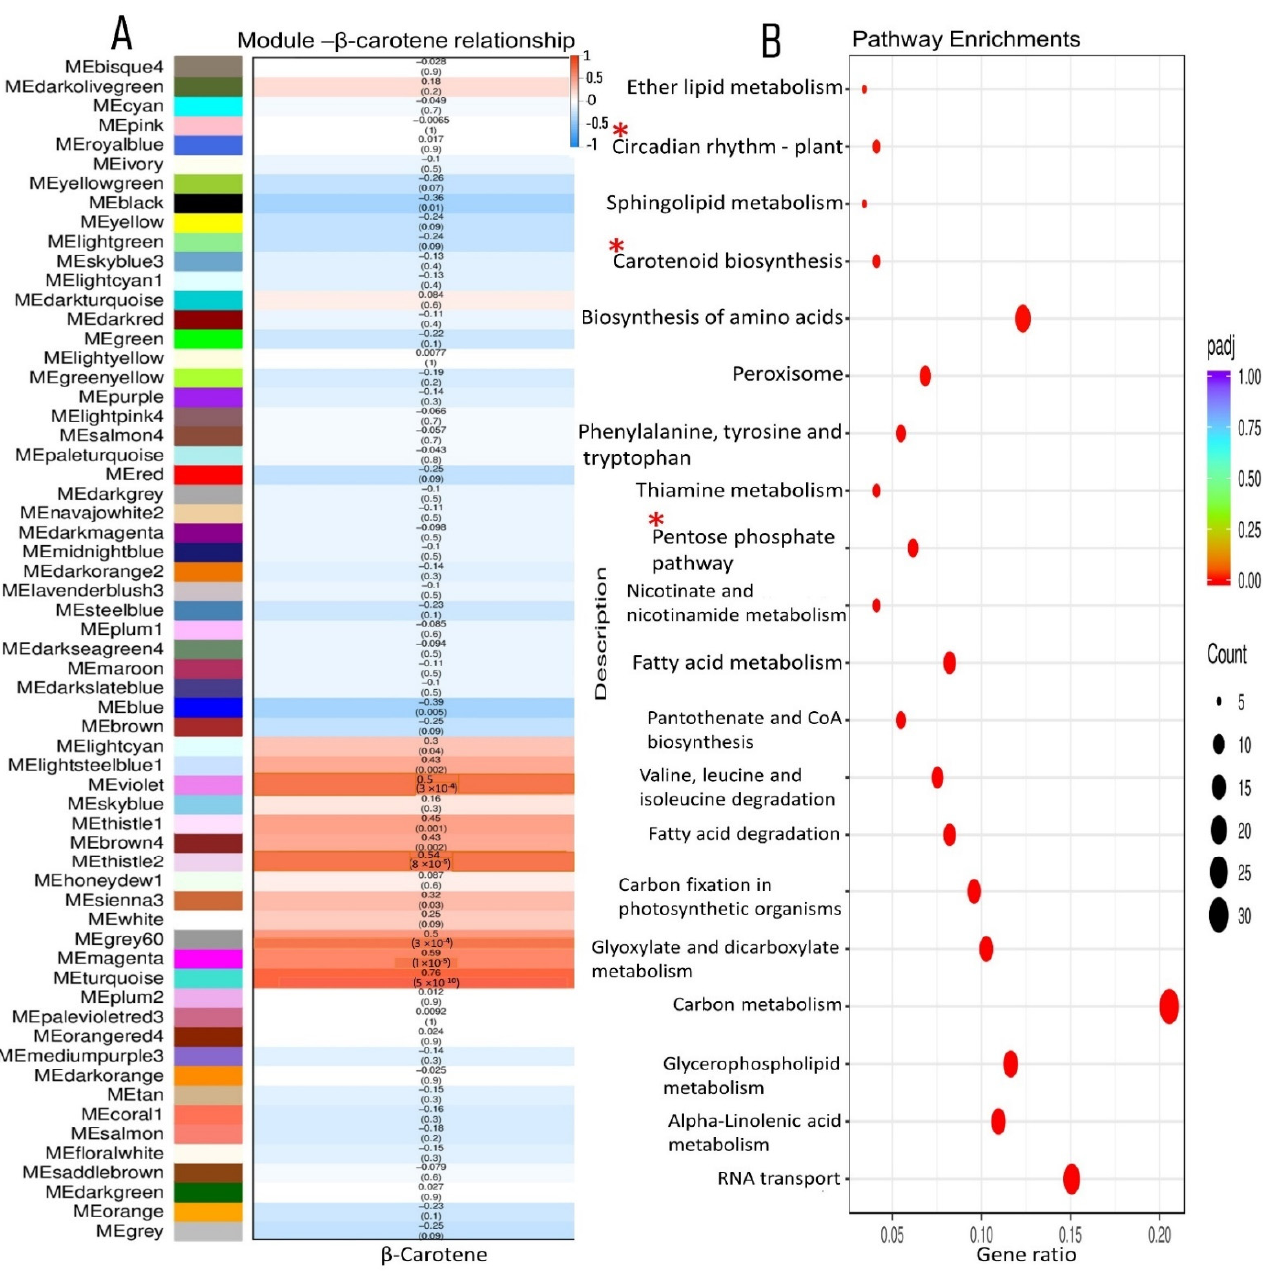
Figure 8. Co-expression networks and associated KEGG pathway enrichment of β -carotene and modules relationships. ( A ) Correlations between modules and β -carotene content; ( B ) Pathway enrichment of genes in the turquoise module positively correlated with β -carotene (R = 0.76). The red stars indicate the significant pathways of interest.